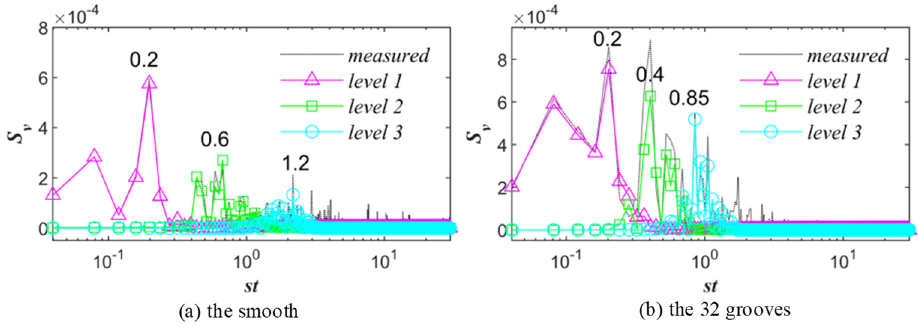
Figure 14. Power spectra of the measured and the three wavelet components at the points x/d = 0.6 and y/d = 0.5.